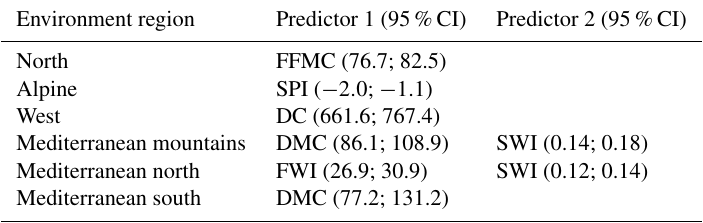
Table A1. Typical range of explanatory variables on a day with large wildfires. The range indicates the 2.5 and 97.5 percentiles (95% confidence interval) of the composite means obtained from 1000 bootstrapped